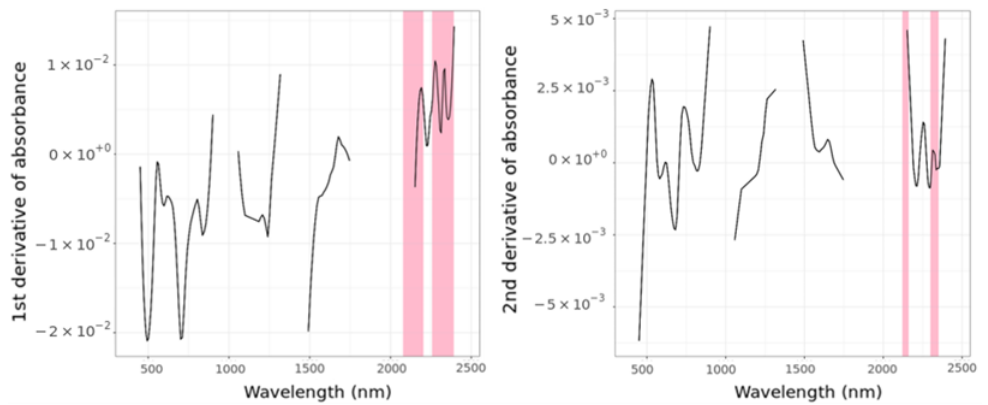
Figure 21. 1st and 2nd derivatives of a PRISMA spectral signature with a high CaCO 3 content. The important spectral regions are highlighted in pink. The interval size varies according to the preprocessing method applied.